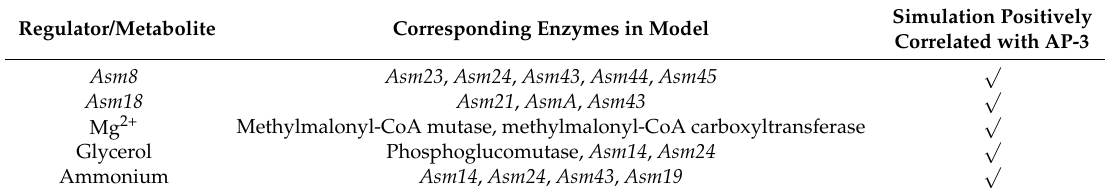
Table 3. The reported key regulators and metabolites for AP-3 production and the robustness simulation of corresponding enzymes in the